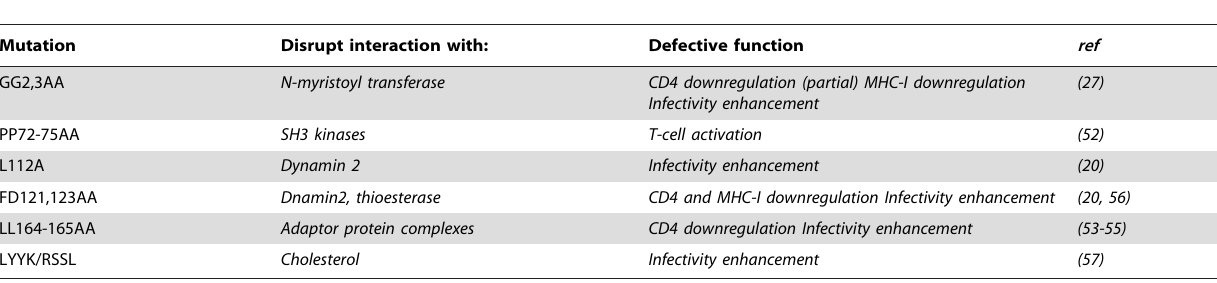
Table 1 . Properties of the Nef mutants analyzed in this study.